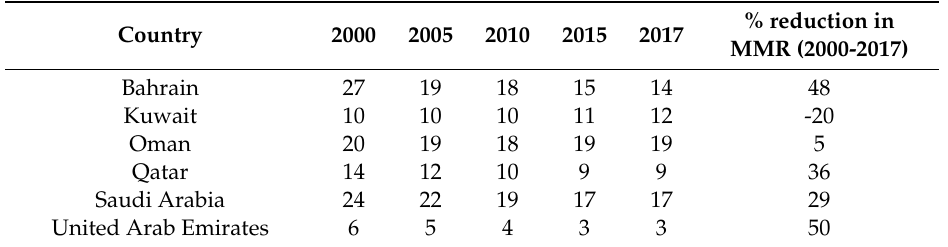
Table 1. Maternal mortality rates (MMR) (deaths per 100,000 live births) in Gulf Cooperation Council (GCC) countries from 2000–2017